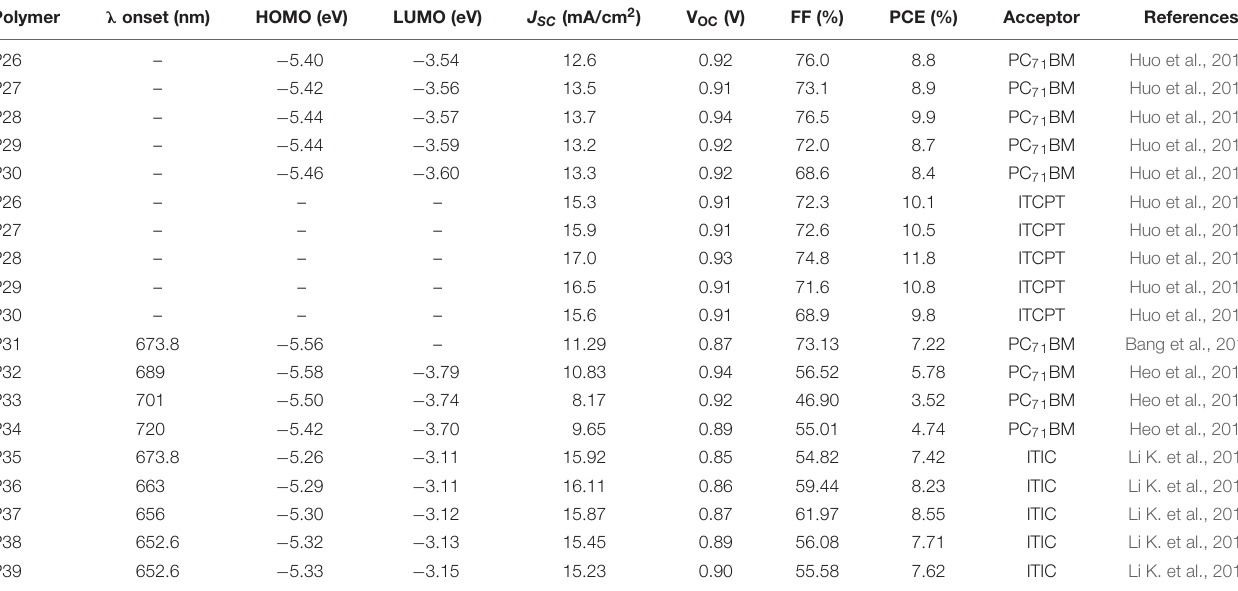
TABLE 3 | Summary of optical, electrochemical, and photovoltaic properties of polymers ( P26 – P39 ). Polymer λ onset